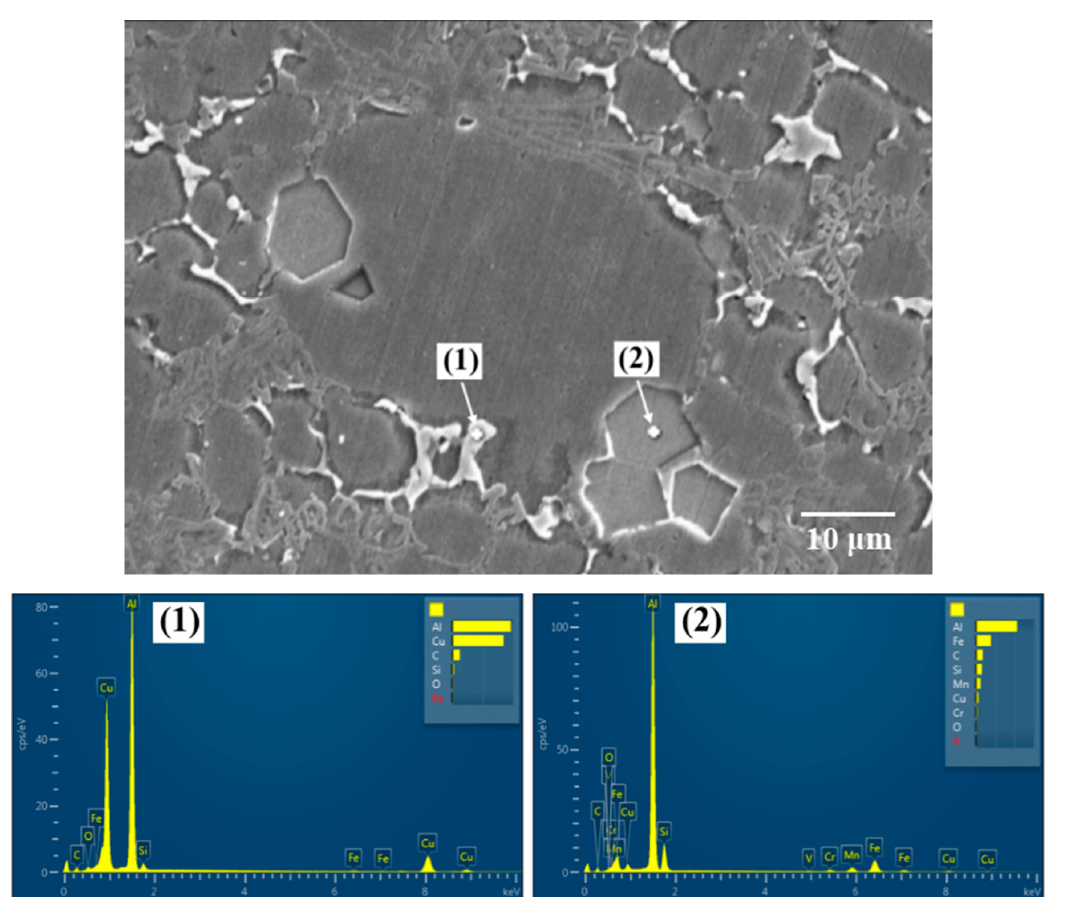
Figure 5. EDS images of Al 2 Cu phase (1) and Al-Si-Fe-Mn phase (2).